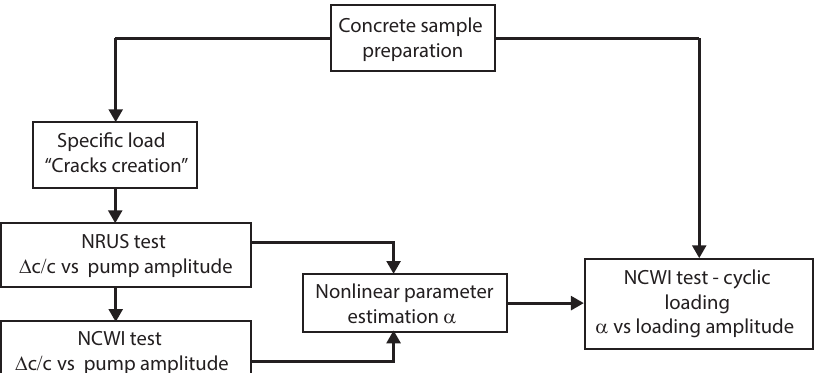
Figure 1. Experimental plan. A cubic concrete sample is submitted to a specific load to induce microcracking and then it is tested by the NRUS technique. This test is used to implement the NCWI method. Once the device settings and processing signal parameters are selected, the NCWI setup is used to test a new concrete sample as a function of the compression loading